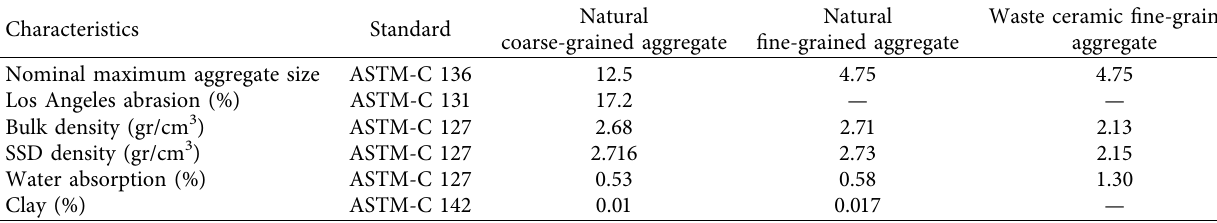
Table 4: Aggregate physical properties.